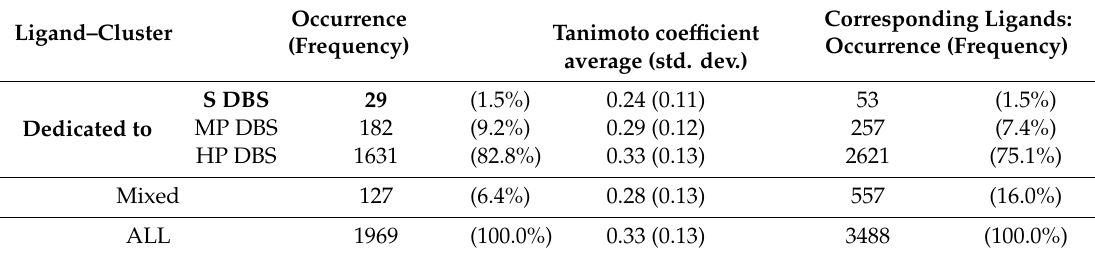
Table 2. Description of the Ligand–Clusters according to the di ff erent promiscuity levels using the DBS4 dataset. Ligands associated with selective (S), MP, and HP DBS are considered as dedicated, and those associated with DBS of di ff erent promiscuity levels are considered mixed. Second column gives the occurrence (and frequency) of Ligand–Clusters according to the promiscuity of DBS to which they bind: 29 were S, 182 were MP, the majority (1,631) were HP, and 127 were mixed, where they bind to DBS of di ff erent promiscuities. From the 127 mixed Ligand–Clusters, eight bound to selective and HP DBS; 26 bound to S, MP, and HP DBS; 88 bound to MP and HP DBS; and, five bound to selective and MP DBS. The third column is the average Tanimoto coe ffi cient between the Ligand–Clusters. Ligands associated with S, MP, and HP were considered dedicated, and those associated with Pocket-Clusters with di ff erent promiscuity levels were considered as mixed. The last column is the number of corresponding